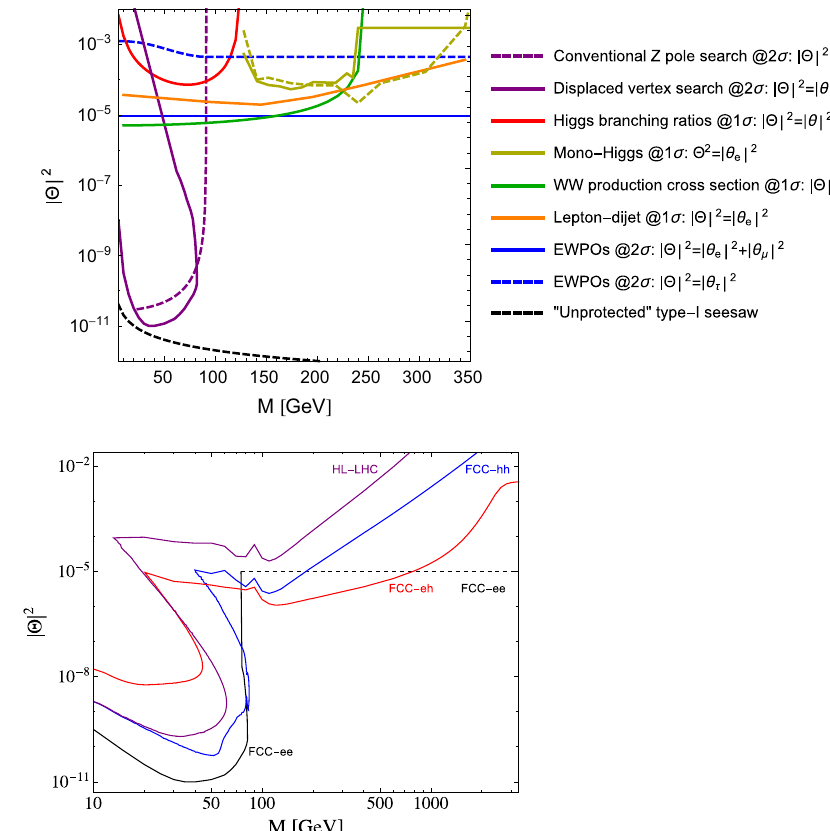
Fig. 13.2 Summary of heavy sterile neutrino search prospects at all FCC facilities. Solid lines are shown for direct searches and the dashed line denotes an indirect constraint. These limits are taken from Ref. [348] where further details of the signatures and searches are provided